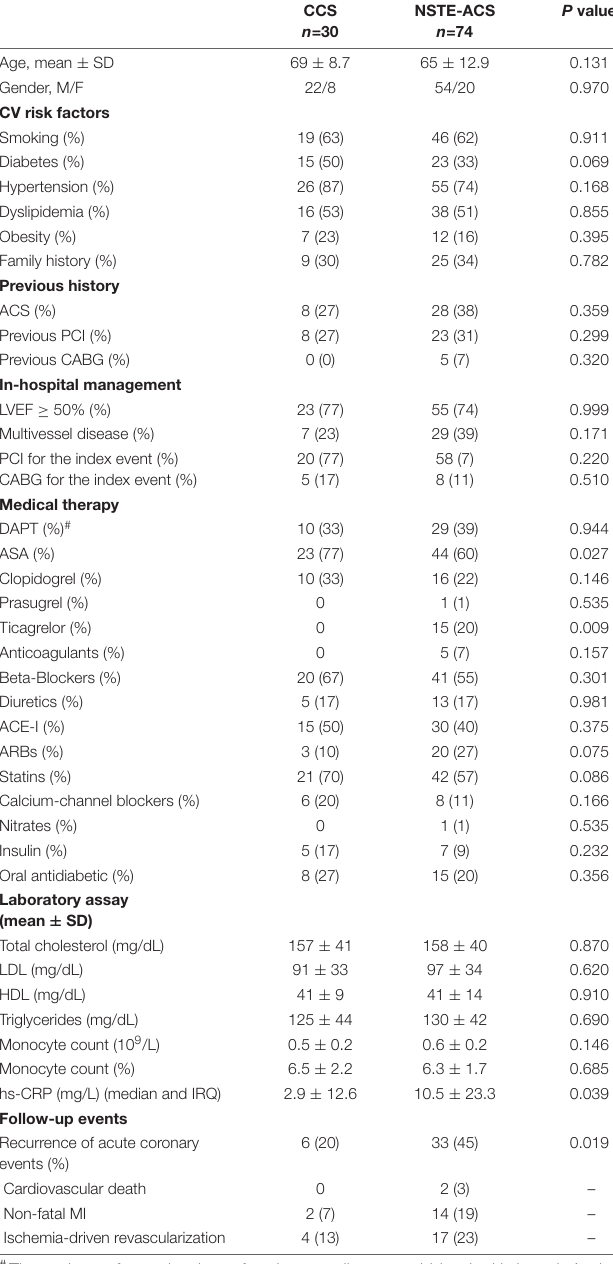
TABLE 1 | Baseline characteristics of the study